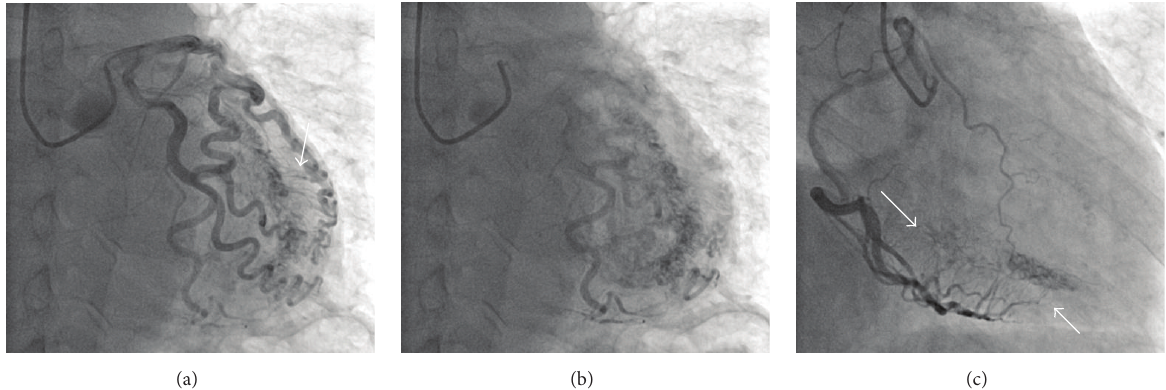
Figure 2: Coronary angiography. (a) A plexiform small coronary artery fistula (arrow) from the left coronary artery to the left ventricle. The left coronary artery was tortuous but showed no significant stenosis. (b) After left coronary angiography, contrast medium was drained into the left ventricle, thereby showing the endocardial border of the left ventricle. (c) Angiogram of the right coronary artery showing multiple microfistulas.